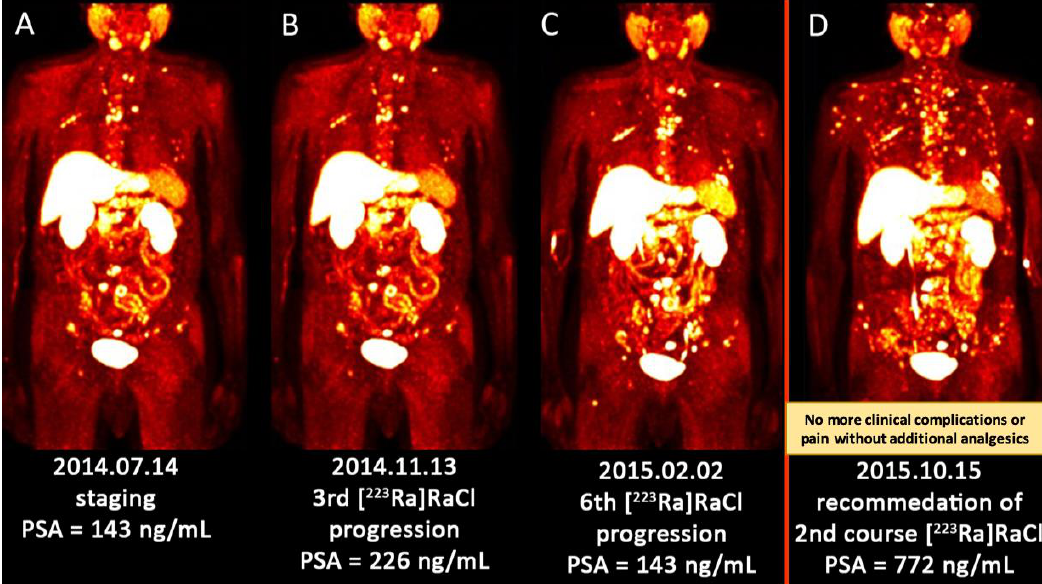
Figure 2. ( A – D ) Sequential images (MIP) of [ 18 F]FCH PET/CT scan from a patient with